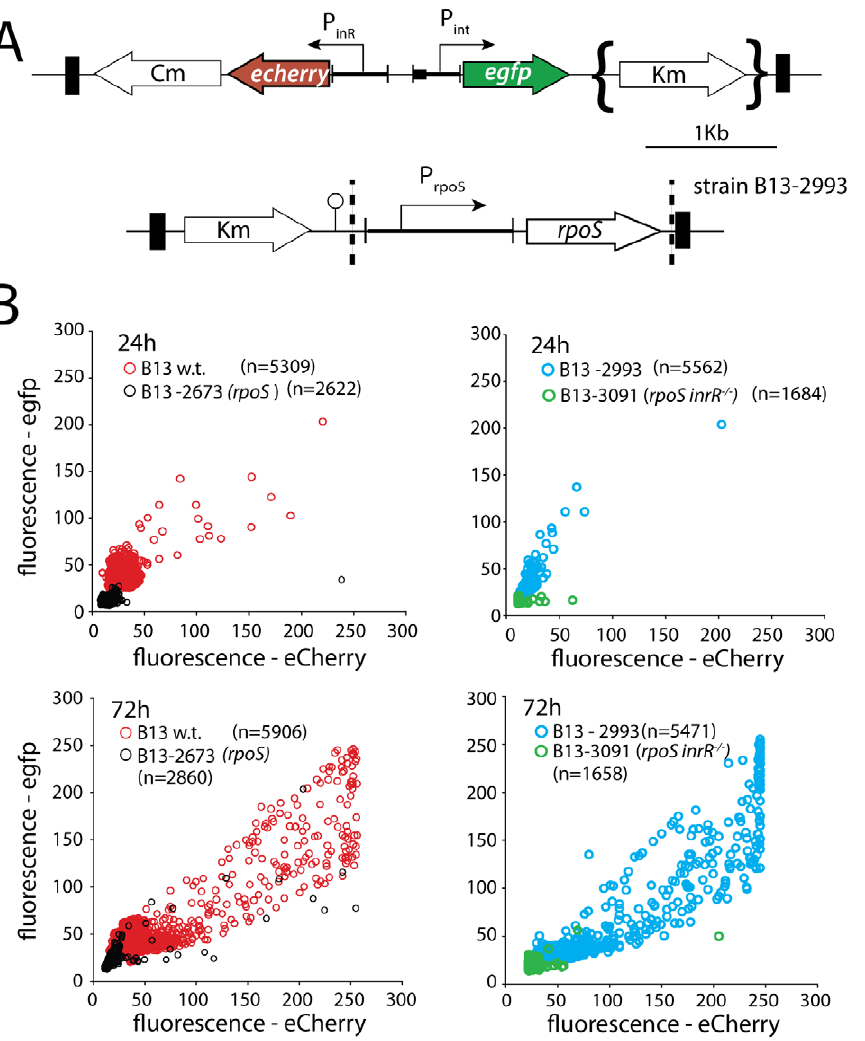
Figure 2. Effect of rpoS interruption on reporter gene expression from two key bistable promoters (P int and P inR ) controlling ICE clc activity in stationary phase P.knackmussii cells grown on 3CBA. (A) Relevant details of the P int - egfp , P inR - echerry mini-transposon reporter construct and of the mini-transposon introducing the native rpoS gene under control of its own promoter (only in the complemented strain B13- 2993, orientation of this insert unknown). Transposon boundaries indicated by thick black lines. (B) Scatter plots showing eGFP (from P int ) and eCherry (from P inR ) fluorescence intensities in single cells (circles) of B13-2581 (wild-type), B13-2673 ( rpoS ), B13-2993 ( rpoS complemented in trans by mini-Tn with rpoS ), or B13-3091 ( rpoS , inrR 2 / 2 ) at 24 h and 72 h in stationary phase. Note the camera saturation in the eCherry channel above 256 units (8- bits). For signal quantification and significance testing, see Table 2.